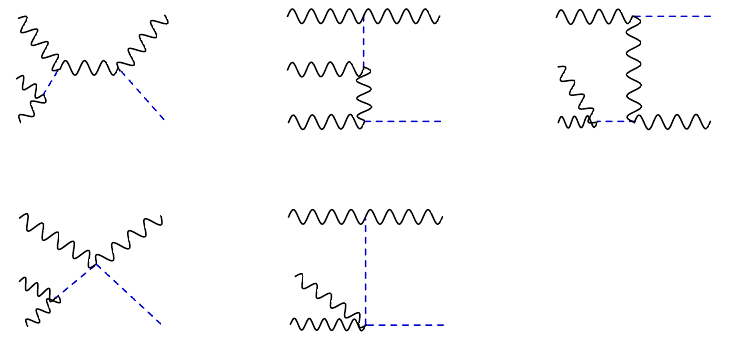
Figure 11 . Feynman diagrams for the annihilation XXX ! XS